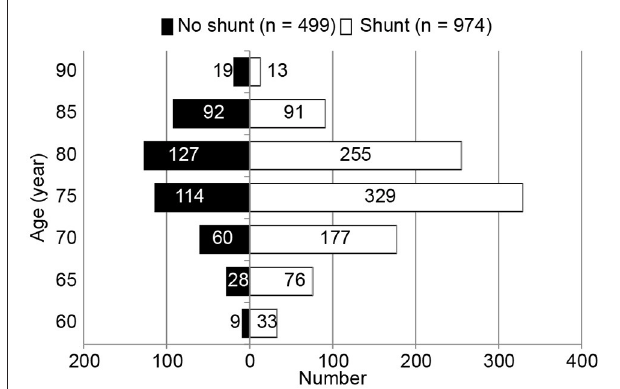
FIGURE 2 | Age-distribution histogram of 1,423 patients with possible idiopathic normal pressure hydrocephalus (iNPH). Data represent the number of possible idiopathic normal pressure hydrocephalus patients ( n = 1,423). Patients were stratified by age groups (5-year age groups ranging from 60 to 94 years of age) to compare the no shunt group with the shunt